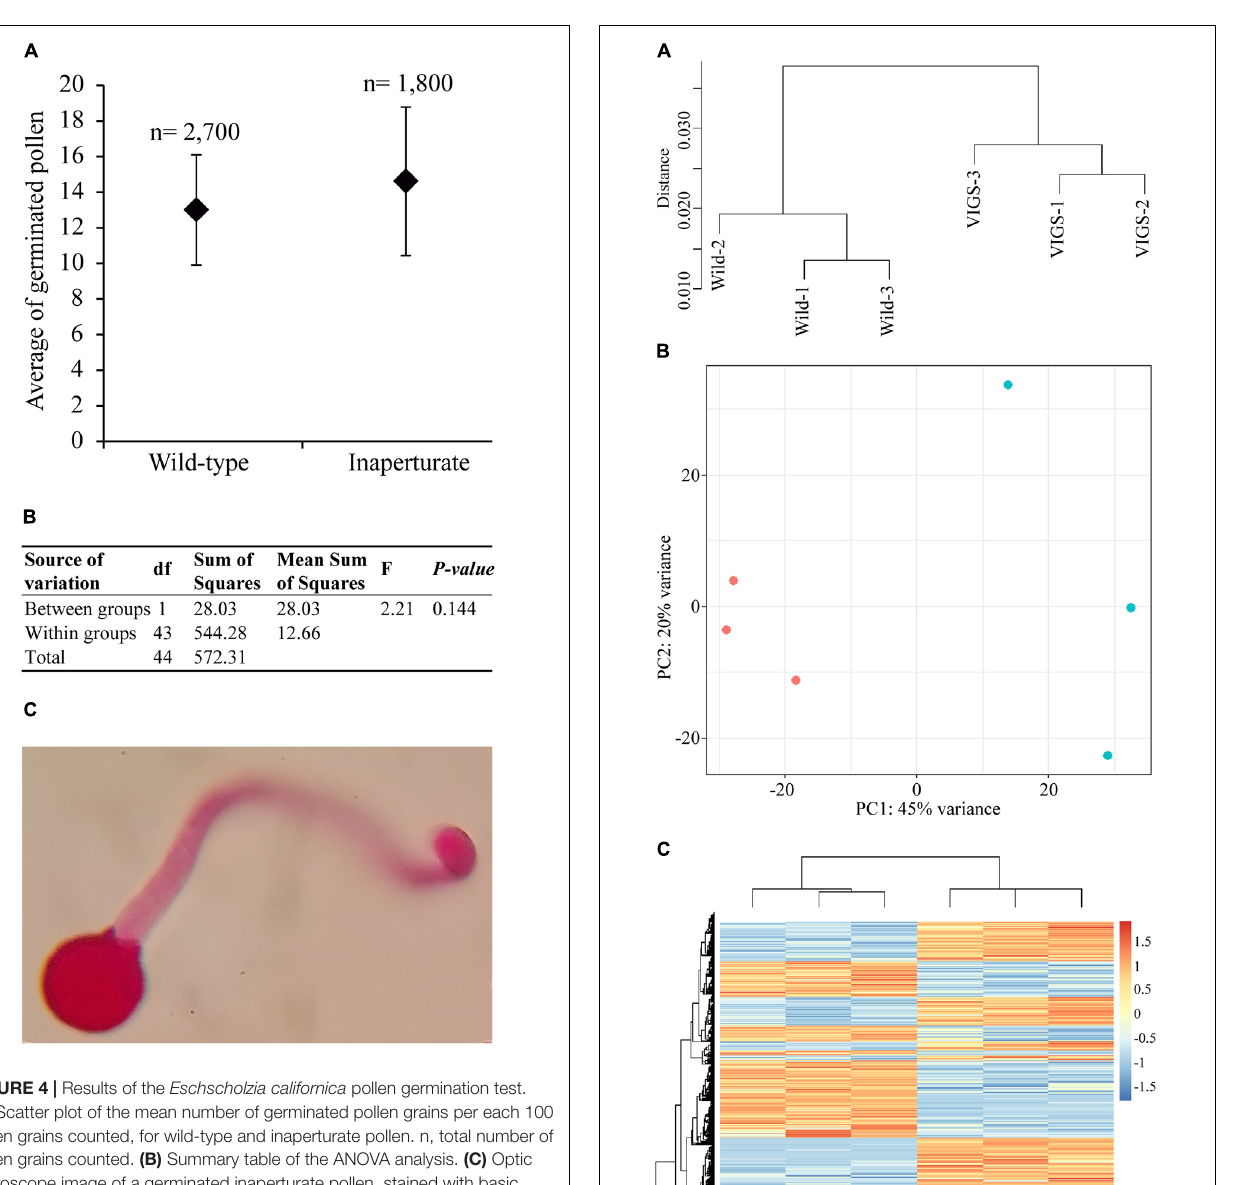
scaffold Eca_sc004639.1_g0030.1) and D6 PROTEIN KINASE-